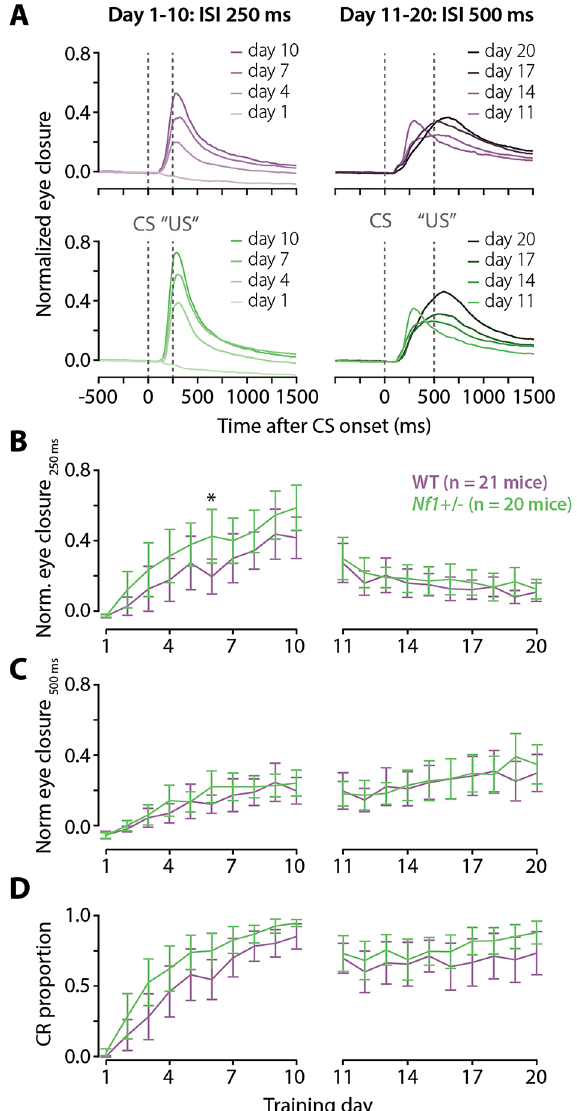
Figure 2. Effect of eyeblink conditioning on eyelid closure and CR proportion. ( A ) Eyeblink traces of normalized eye closure averaged per genotype and training day (first and every subsequent third day). ( B ) Normalized eye closure measured at 250 ms after the CS onset. ( C ) Averaged normalized eye closure measured at 500 ms after the CS onset. ( D ) CR proportion. The left column of figures describes the 250 ms ISI training phase, where the right column describes the subsequent 500 ms ISI training phase. Green data represents Nf1 +/− mice. Purple data represents WT mice. All error bars represent 95% confidence intervals. *p < 0.05 after correction for multiple